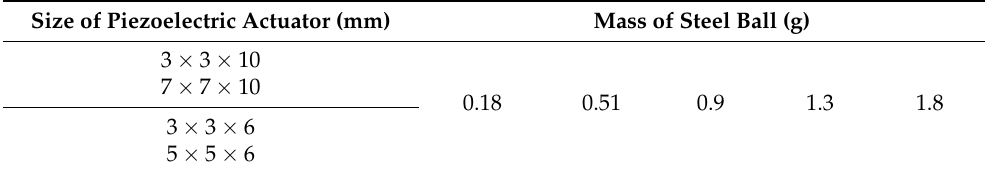
Table 4. Parameter table for the second set of